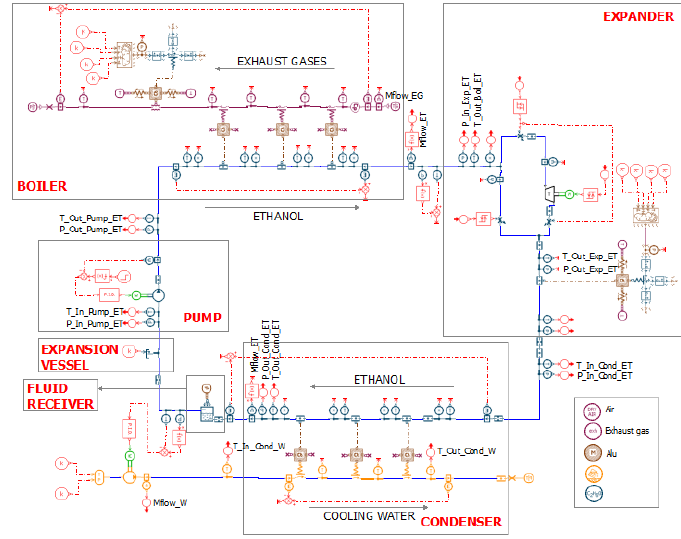
Figure 6. ORC model. Working fluid.